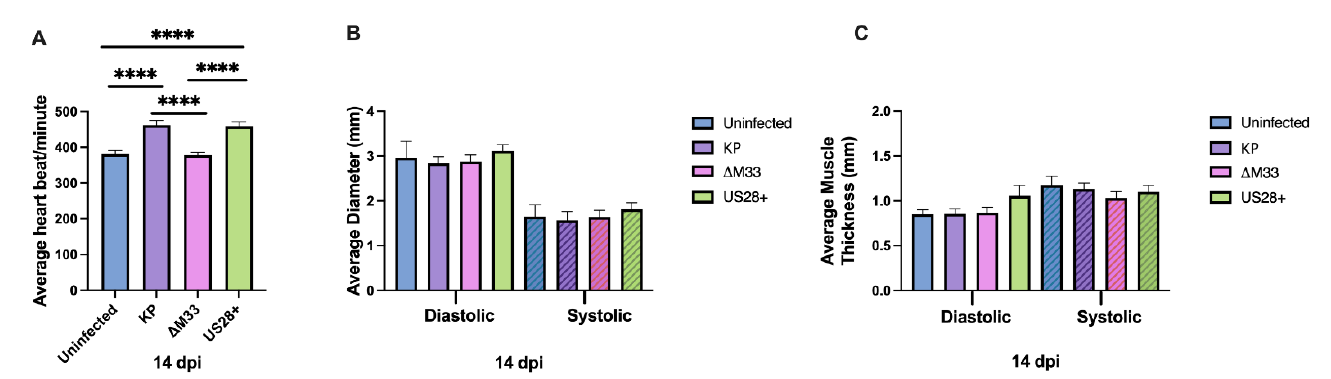
Figure 3. M33 and US28 promote acute tachycardia. Mice were uninfected or infected with 1 × 10 6 PFU i.p. At 14 dpi, echocardiography was conducted: ( A ) heart rate, ( B ) left ventricular internal diameter, and ( C ) left ventricular posterior wall thickness were evaluated. Group mean and standard error of the mean were calculated. Significance was determined by ANOVA and Tukey’s multiple comparisons test. **** p = 0.0001. Studies were conducted in duplicate ( n = 10).